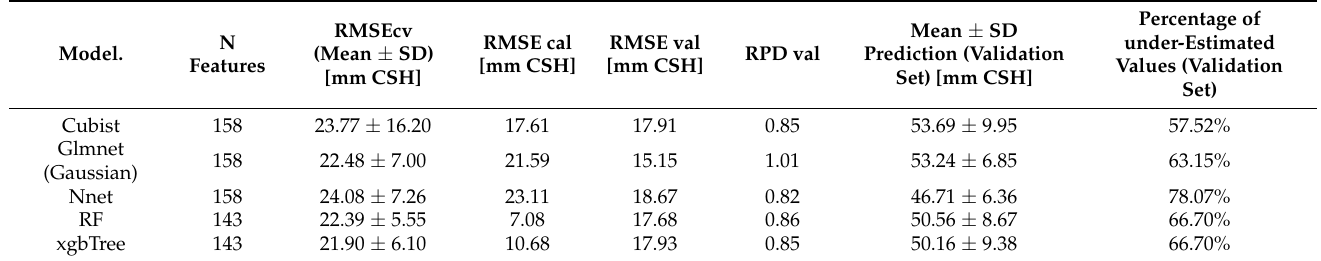
Table 3. Performances of the newly trained models with the new data and feature definition. (RMSEcv = cross-validation root mean squared error (RMSE); RMSEcal = calibration RMSE; RMSEval = valida- tion RMSE; RPD = validation standard deviation (SD)/validation